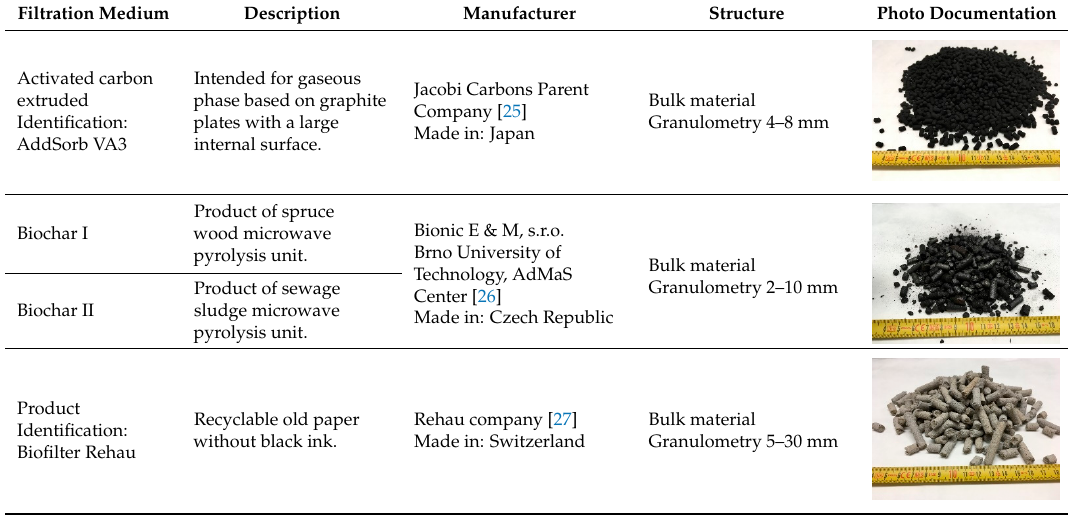
Table 3. Selected filter medium pelletized.